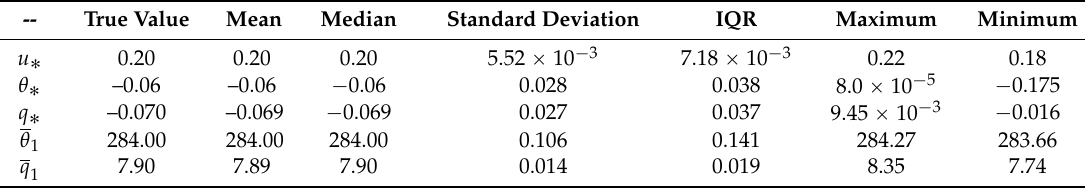
Table 2. Statistical characteristics of the estimator. The units are the same as in Table 1.